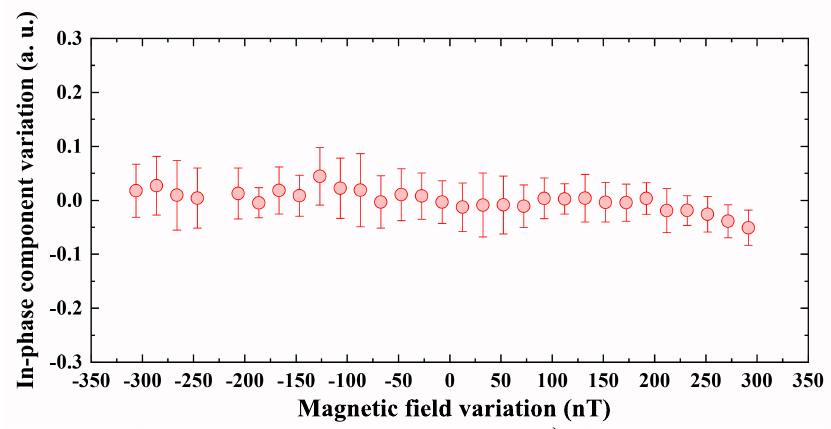
Figure 5. The dependence of the in-phase component signal amplitude with different magnetic field. The error bar is from eight individual